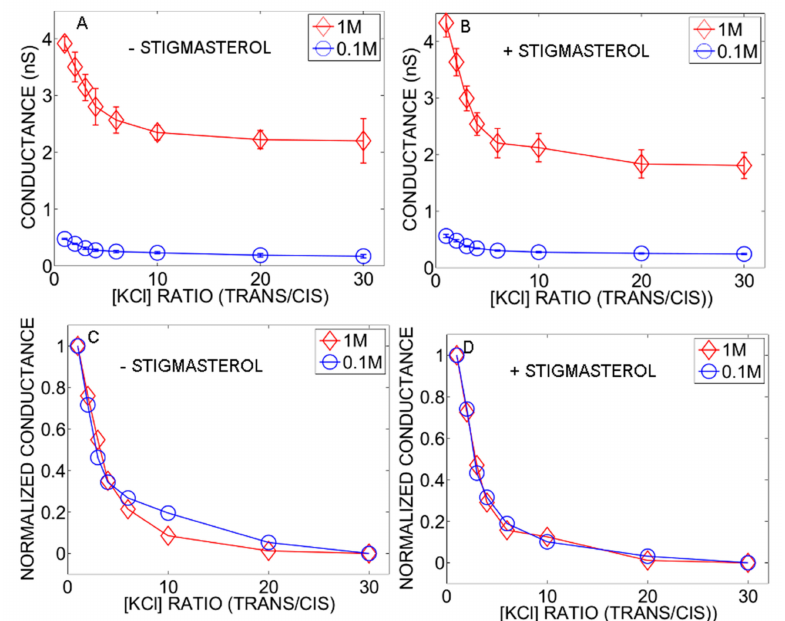
Figure 5. Changes in single-channel conductance with KCl concentration ratio (Trans/Cis). The ion concentration in the Trans compartment was fixed at either 1 M (red diamond,) or 0.1 M (blue